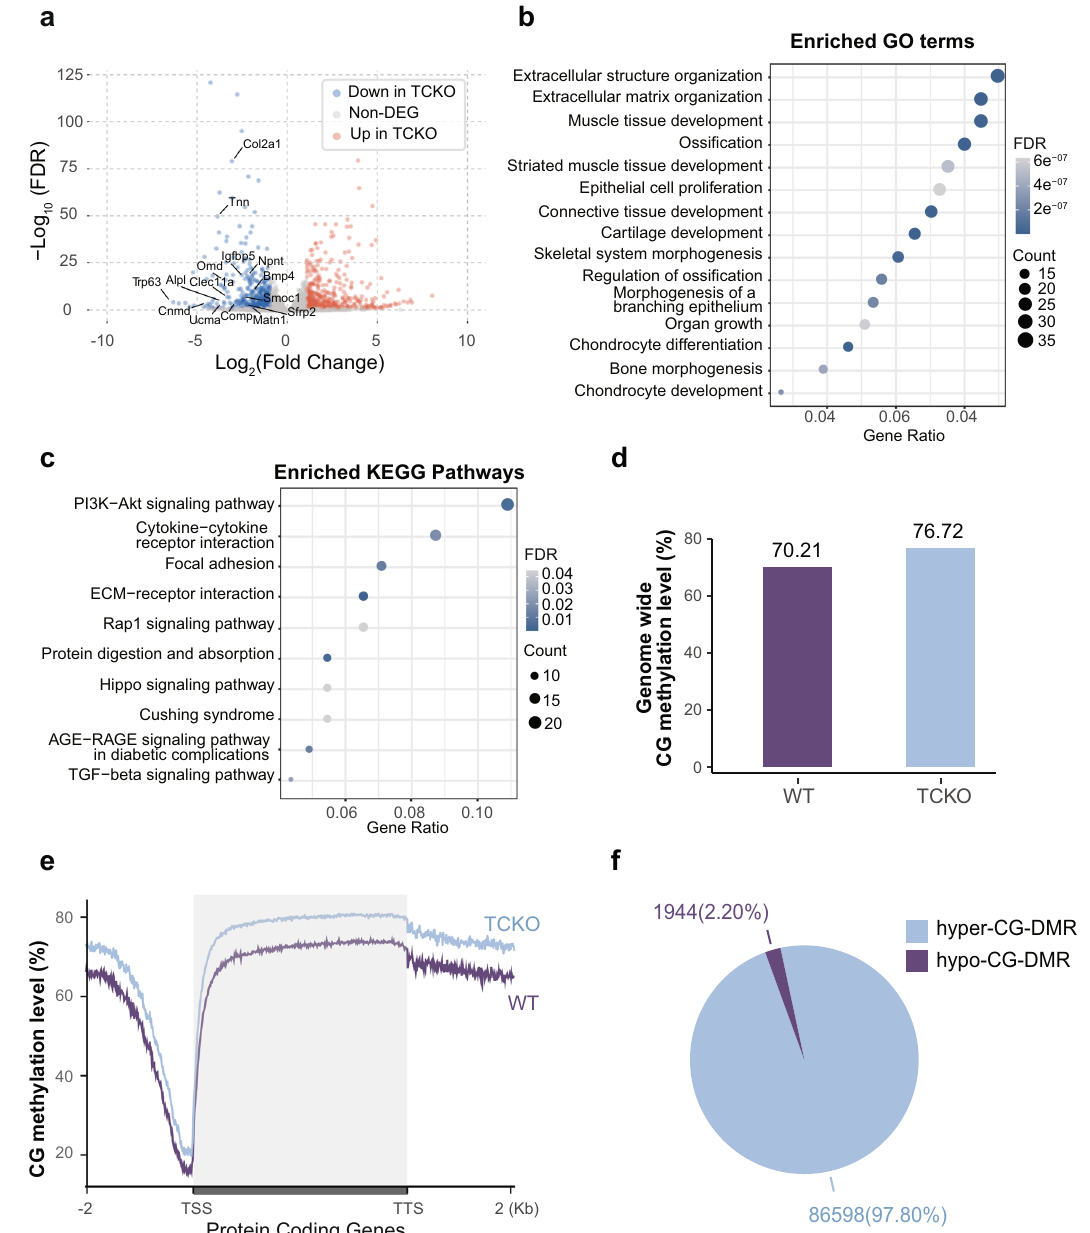
Fig. 4 | Genome-wide differentially gene expression and DNA methylation patterns between TCKO and WT cells. a Volcano plot of differential expressed protein-coding genes (Fold Change greater than 2 and FDR less than 0.05). b , c EnrichedGOterm( b )andKEGGpathway( c